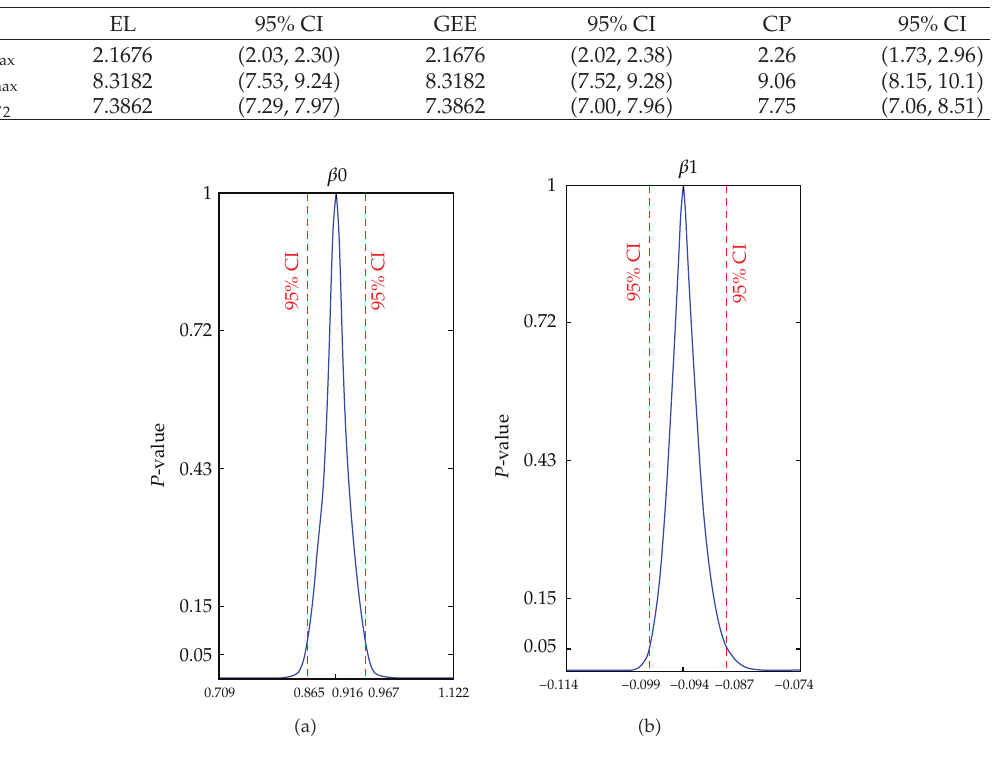
Figure 1: The estimated value of β and its confidence